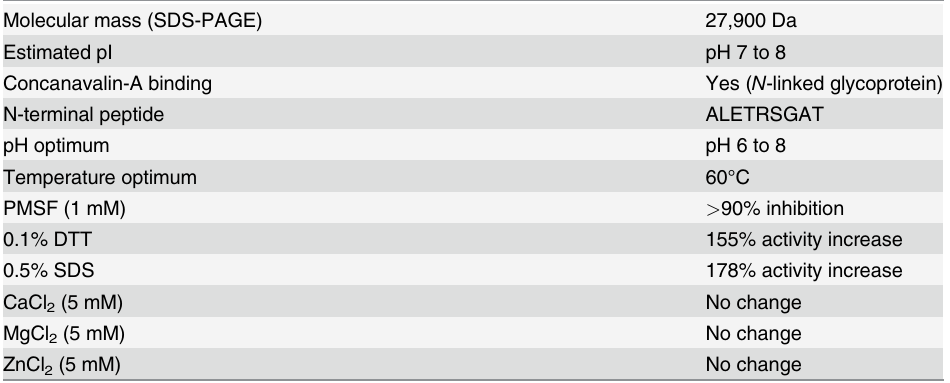
Table 1. Properties observed for the Pseudogymnoascus destructans serine protease isolated by ConA lectin af fi nity chromatography. Molecular mass